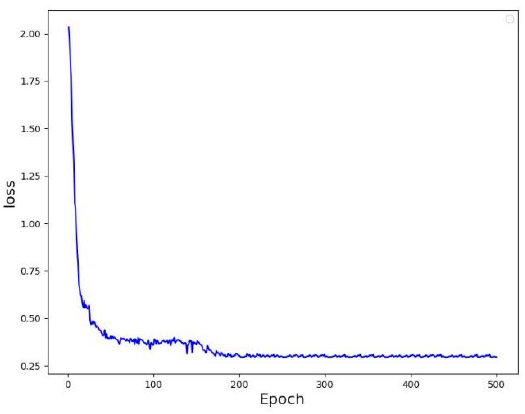
Figure 6. Model training results graph. Table 2. Comparison of detection results of different models.